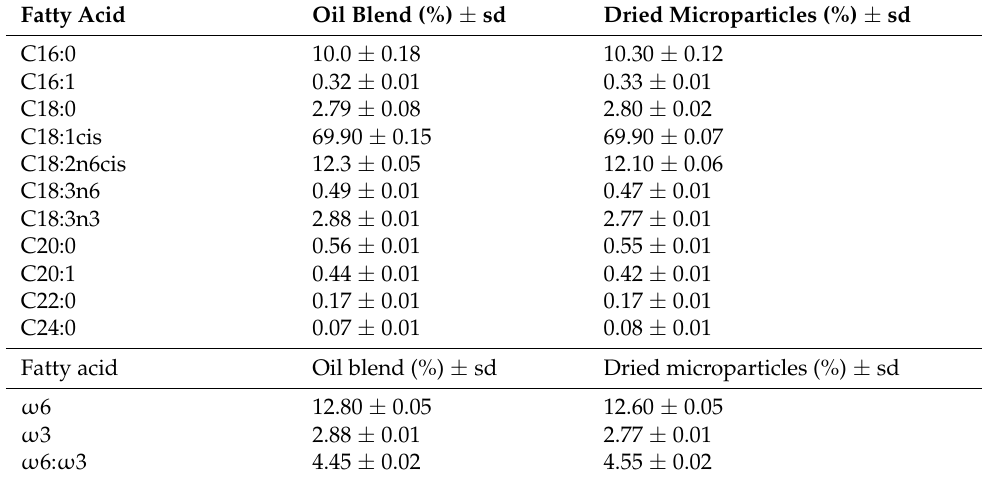
Table 1. Fatty acids content of the vegetable oil blend and ω 6: ω 3 ratio.